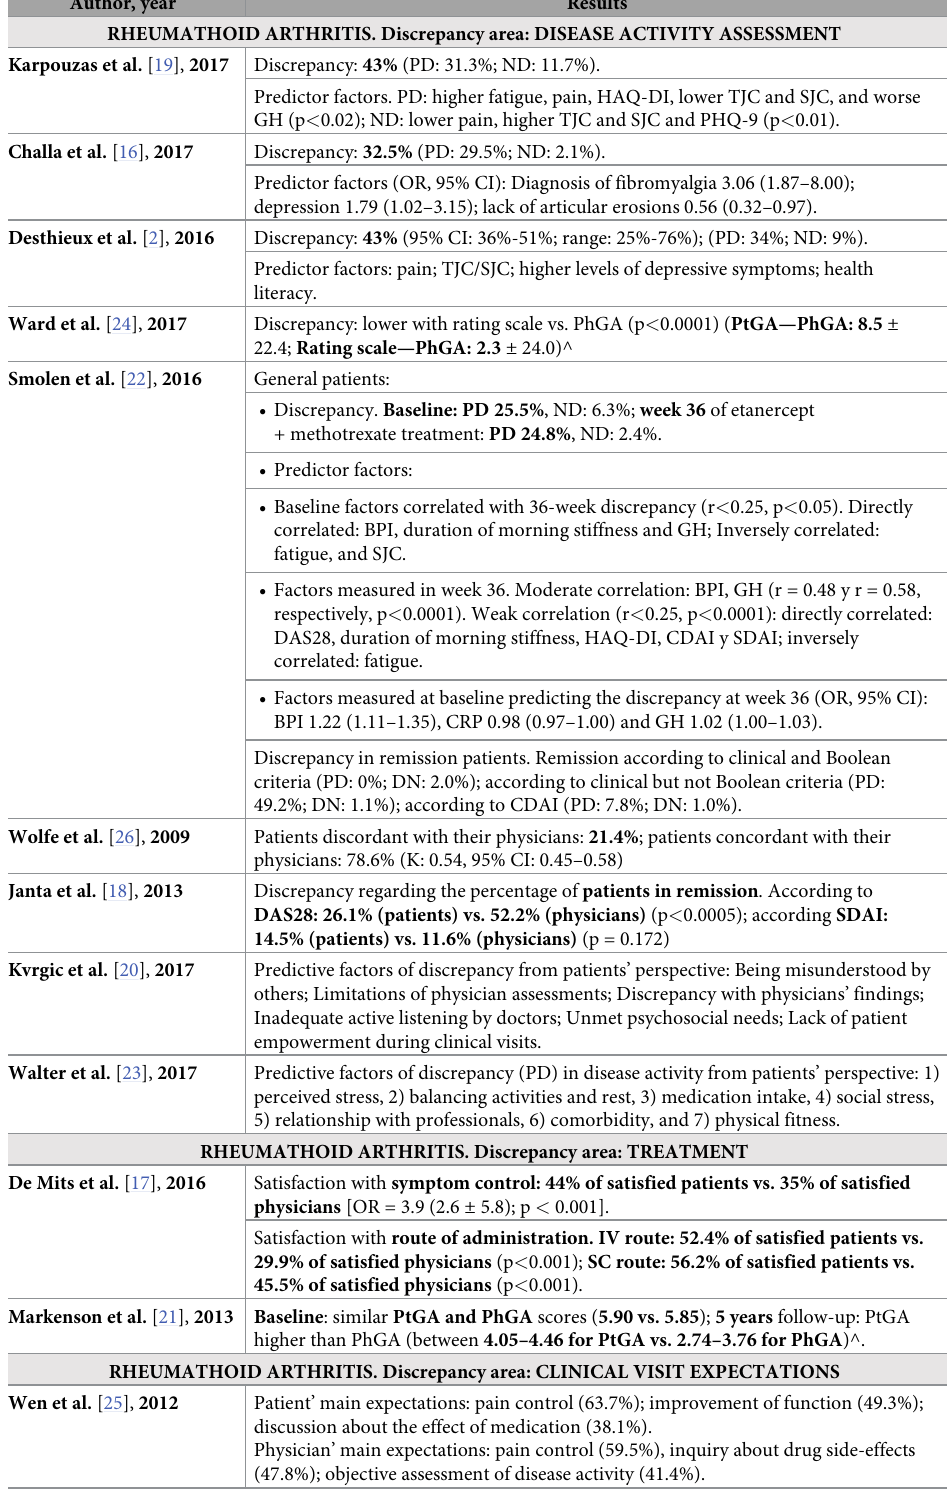
Table 2. Discrepancy and predictor factors in rheumatoid arthritis, psoriatic arthritis and